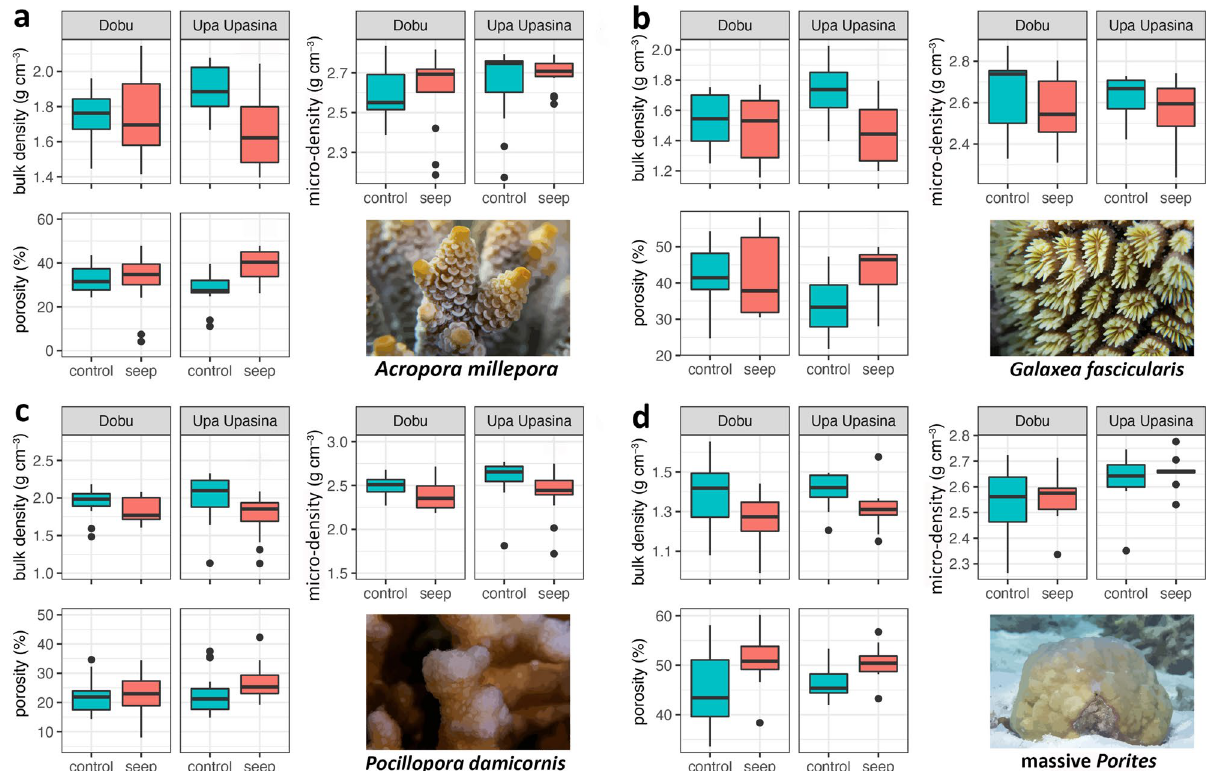
Figure 2. Skeletal parameters micro-density, porosity and bulk density at control (green box plots) and seep sites (pink box plots) in Dobu and Upa Upasina (UPA) for ( a ) Acropora millepora , ( b ) Galaxea fasciularis , ( c ) Pocillopora damicornis , and ( d ) massive Porites . The boxes indicate the 25th and 75th percentiles and the line within the boxes mark the medians. Whisker length is equal to 1.5 × interquartile range (IQR). Circles represent outliers. Statistical analyses for these data are reported in Tables 2 and 3. Plots were created with the R package ggplot2 62 . Plots were created with the R package ggplot2 62 . (photographs by co-author FR).